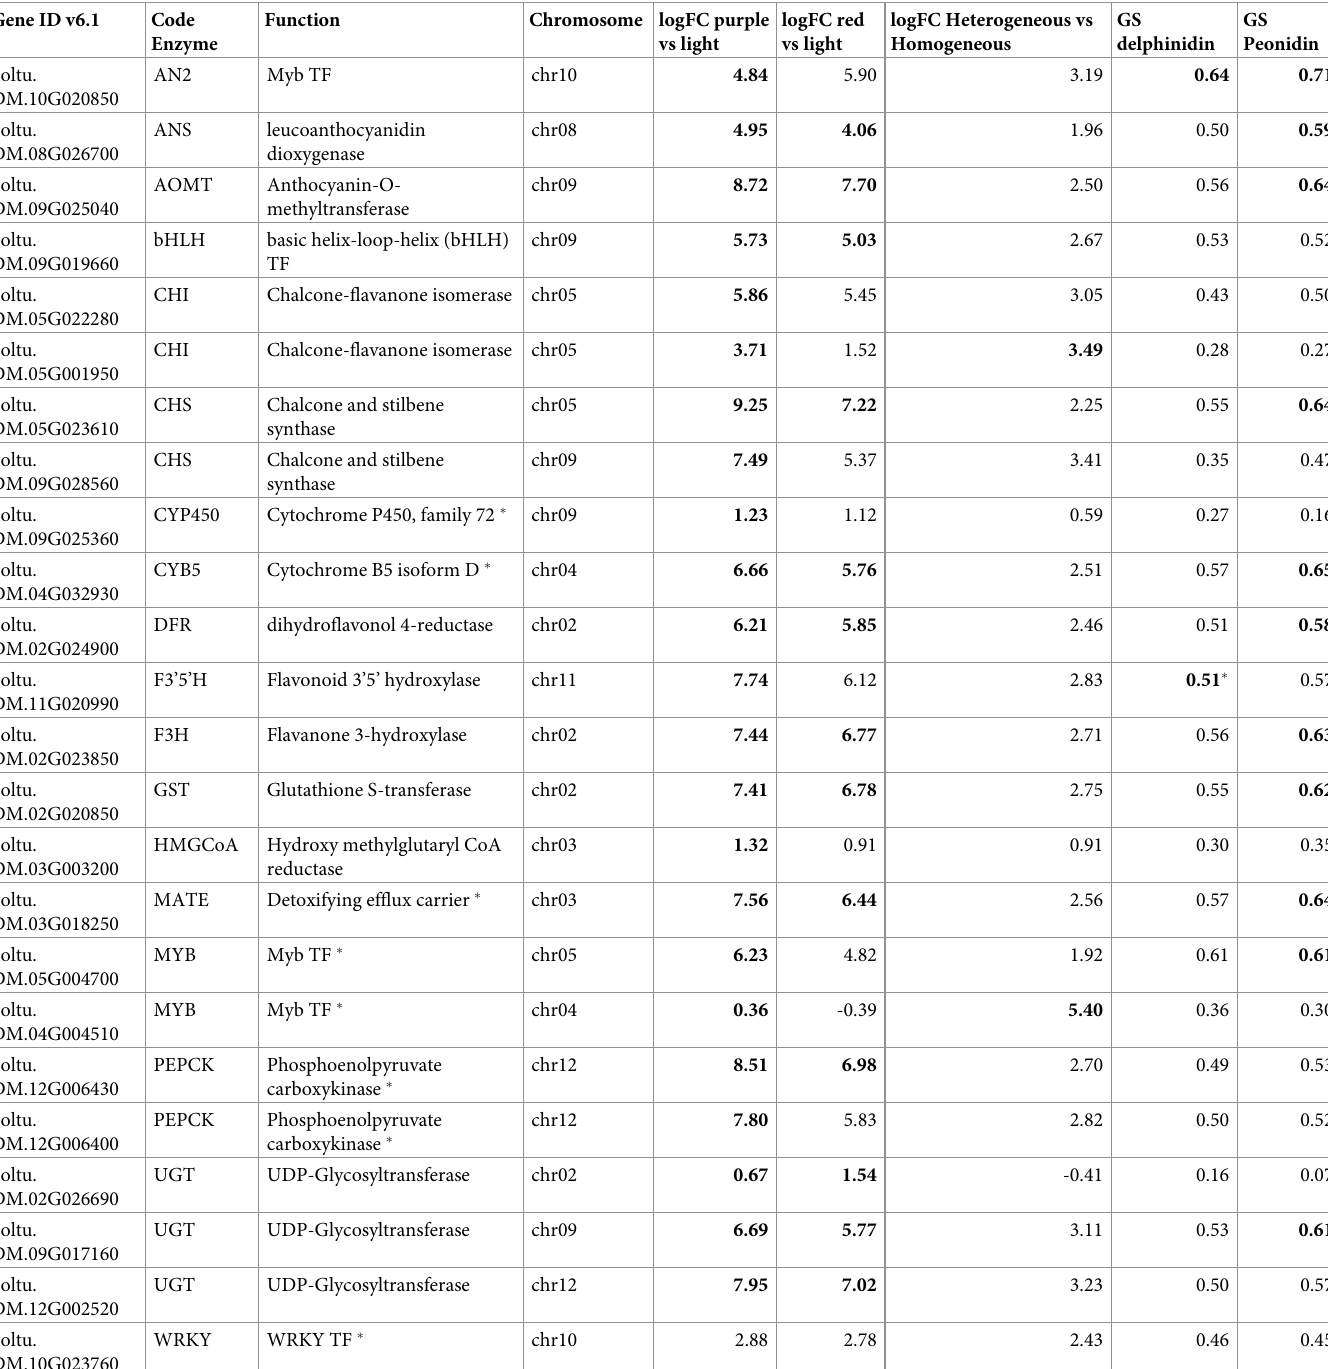
Table 1. Analysis of differentially expressed genes and their correlations with anthocyanins. Summary of the Logarithm of Change in Expression (LogFC) values for the differential expression analyses, and the correlation values between the expression of these genes with the content of the anthocyanins delphinidin and peonidin. Values highlighted in black present significant p-values <